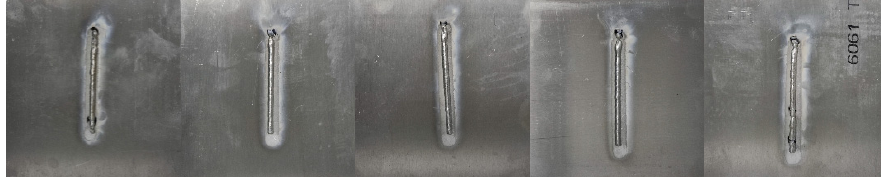
Figure 3. Specimens of WAAM with different heat input.